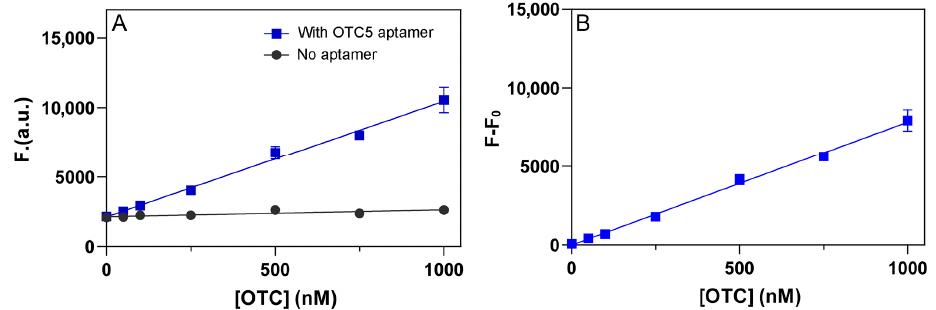
Figure 9. ( A ) Fluorescence intensity as a function of OTC concentration in spiked milk samples after extraction without and with 2 μ M OTC5 aptamer at pH 6.0 with 2 mM Mg 2+ . ( B ) Fluorescence dif- ference of the two curves in ( A ) as a function of OTC concentration at pH